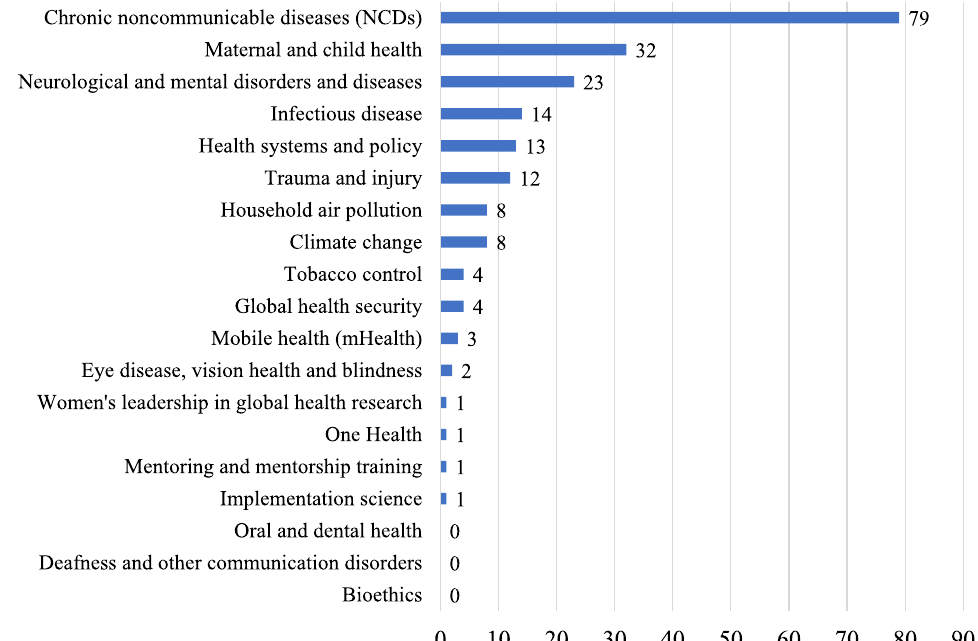
Fig. 1 Yearly peer-reviewed publications with data from outside of China by ten founding members of the Chinese Consortium